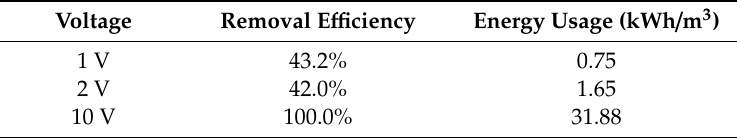
Table 2. The removal e ffi ciency of low and high voltages during the electrocoagulation of celestine blue